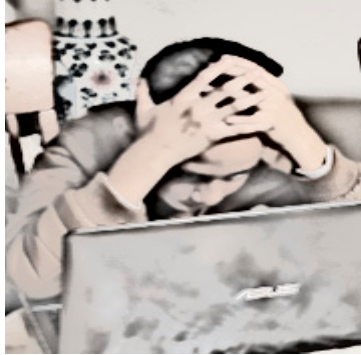
Figure 6. Adel (160) putting his hands on his head.